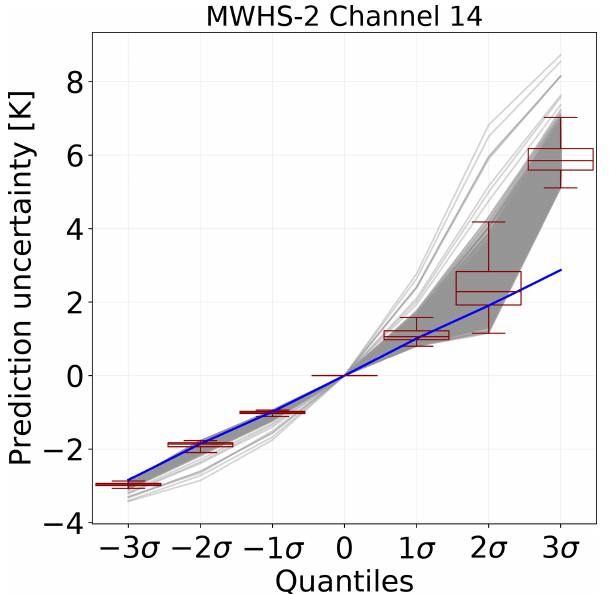
Figure 6. Examples of prediction uncertainties obtained from QRNN-single (89 + 150GHz) for MWHS-2 channel 14. In total, 1500 randomly selected cases are shown. The quantiles have been plotted at equidistant points. The blue line represents a Gaussian distribution with a standard deviation of 1 . 0K. For each quantile, the sample variation is also shown as box plot.